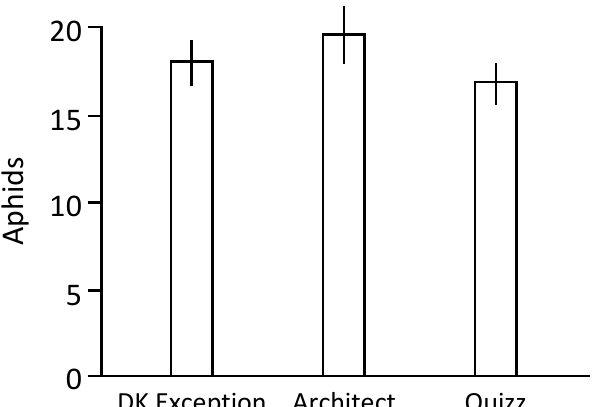
Figure 2. Number of aphids produced from a single L 1 larvae of Mp34. Aphid larva L 1 obtained from synchronized Mp34 population were placed on rapeseed plants in order to measure the size of the population produced in a 9 days period. The average population sizes obtained are presented. The experimental procedure, carried out on a series of 20 plants per genotype, was repeated 3 times. The vertical bars represent the standard deviations associated with the data.